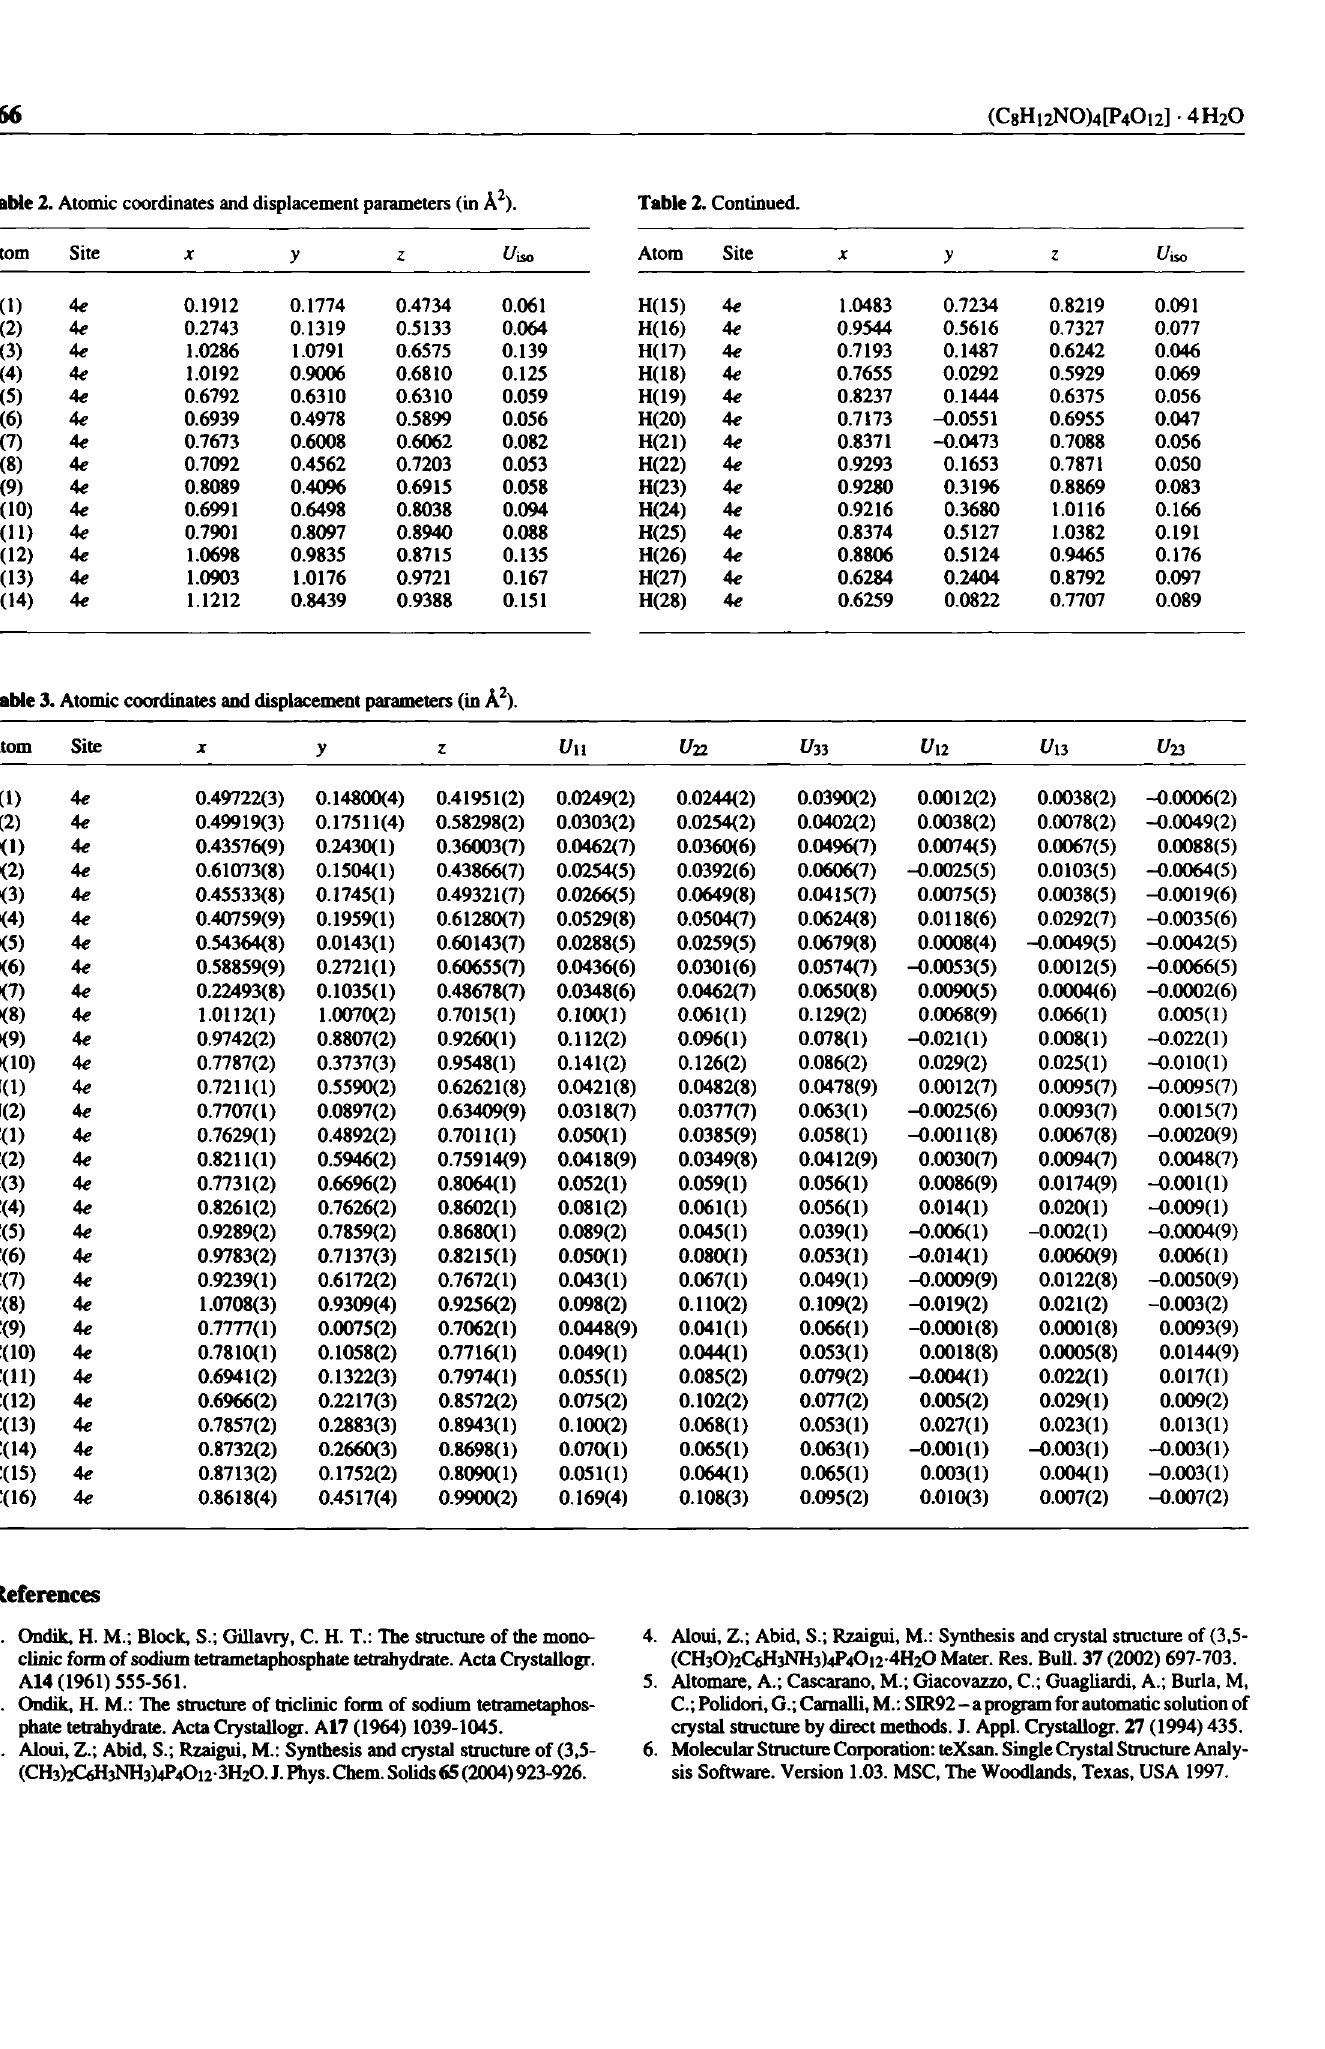
Table 3. Atomic coordinates and displacement parameters (in A 2